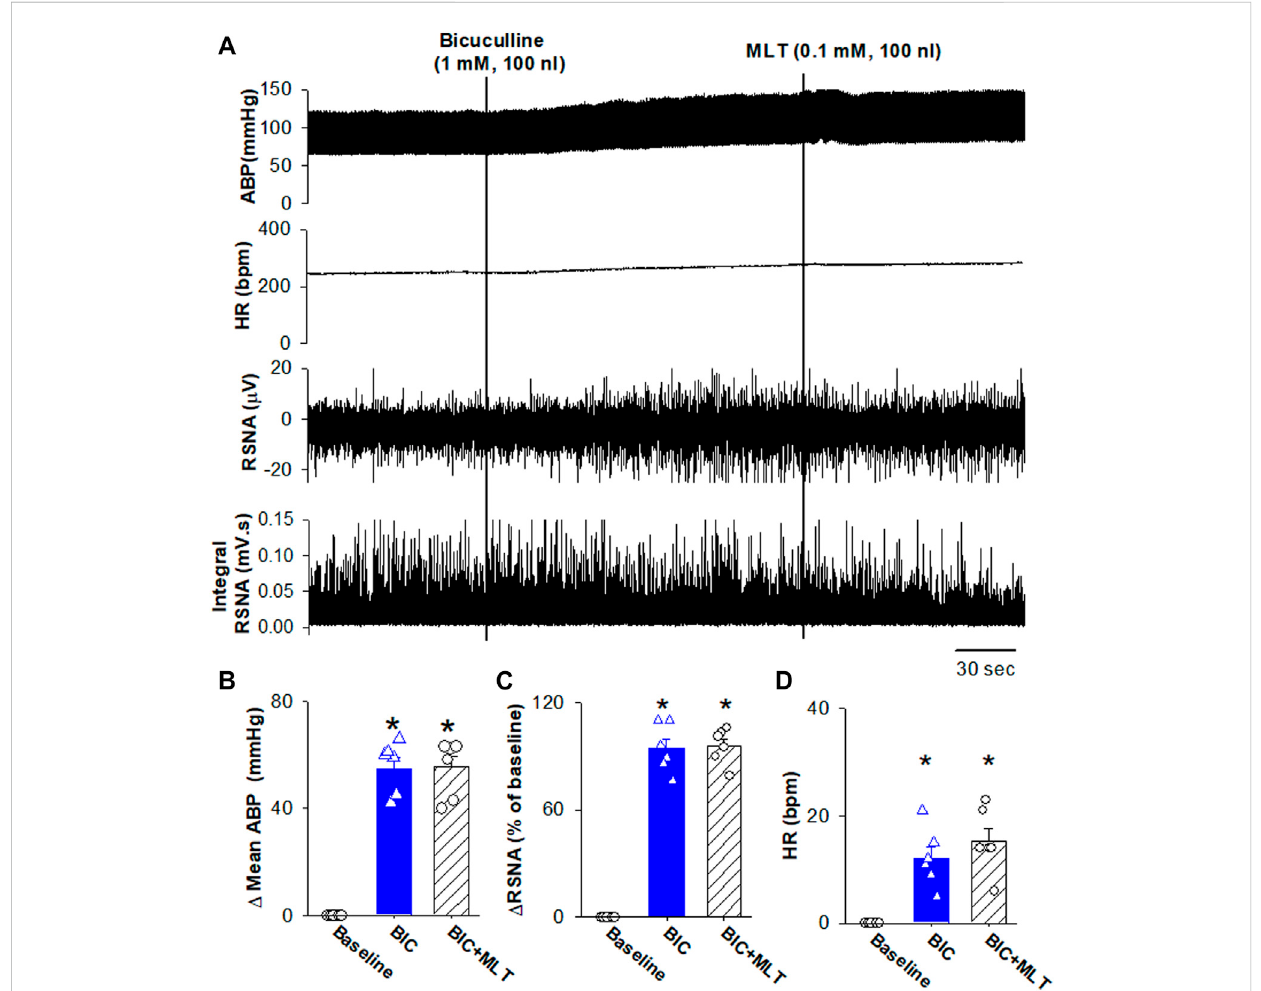
FIGURE 7 Blocking GABAA receptors in the PVN eliminated melatonin-induced decrease in blood pressure and sympathetic out fl ow. (A) , Representative raw traces show the effect of microinjection of bicuculline into the PVN increased ABP, RSNA, and HR. Subsequent microinjection of melatonin into the PVN didnotsigni fi cantlyaltertheABP,RSNA,andHR. (B – D) ,SummarydatashowchangesinmeanABP (B) ,RSNA (C) ,andHR (D) inresponsetomicroinjection of bicuculine and melatonin into the PVN (n = 6). Data are presented as means ± SEM (* p < 0.05 compared with the control; ANOVA, followed by Dunn ’ s post hoc test). MLT,